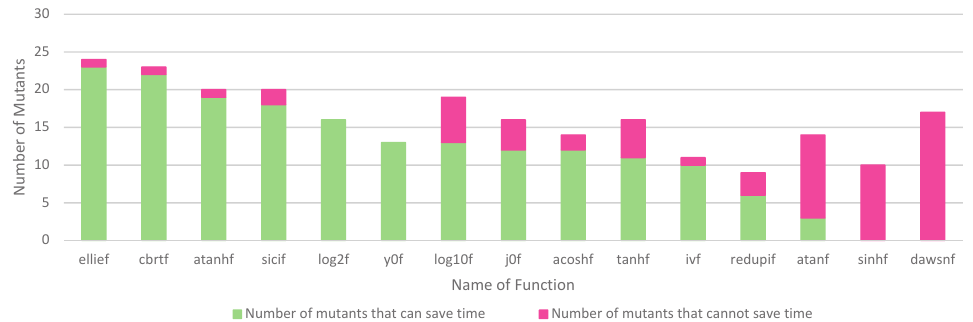
Figure 5. Overview of the Effect of CPA on Fault Detection